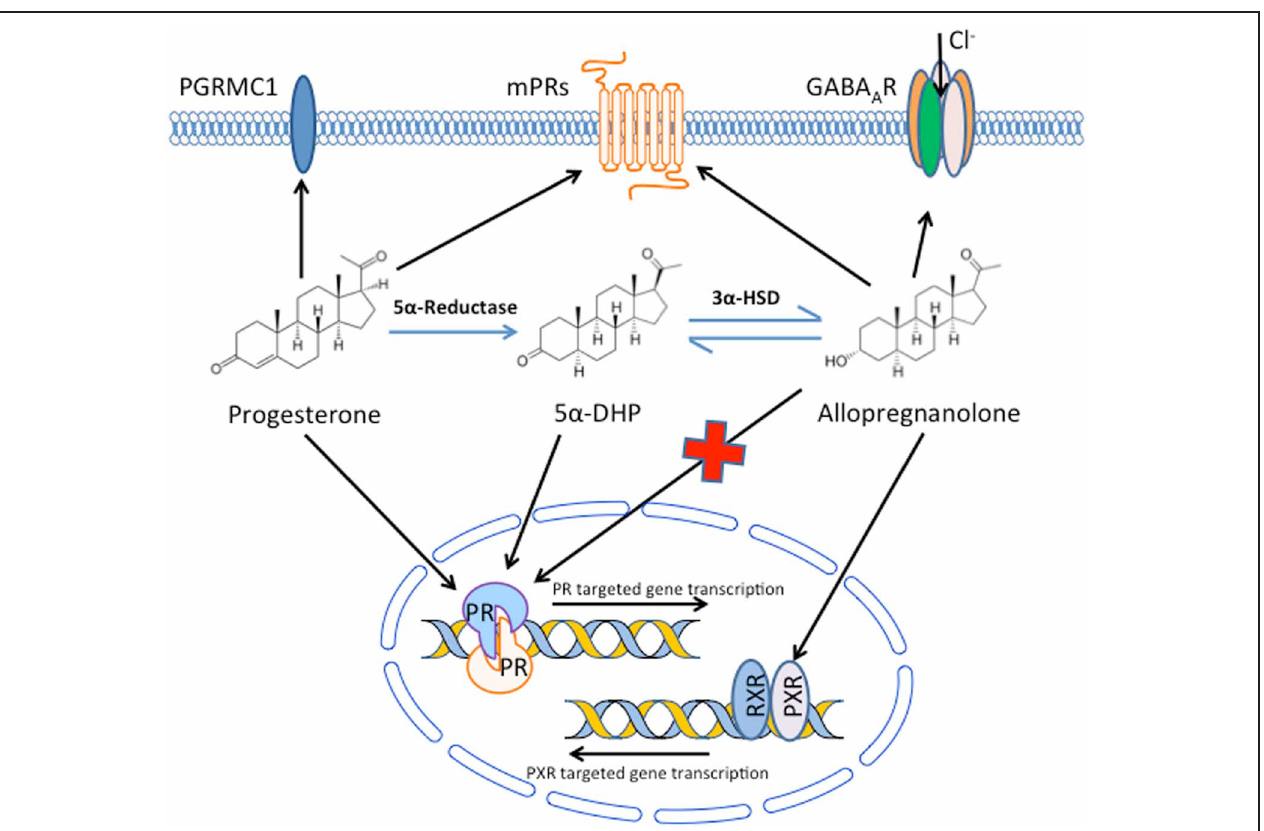
FIGURE 1 | Potential mechanisms by which progesterone and its metabolites signal in the brain to produce beneficial effects following traumatic brain injury. Progesterone, either from the systemic circulation or produced locally in the brain, can bind and signal through the classical nuclear progesterone receptors, but also binds receptors in the plasma membrane, including PGRMC1 and a family ( α – ε ) of membrane progesterone receptors (mPRs). In addition, progesterone can be converted to 5 α -dihydroprogesterone (5 α -DHP) and then allopregnanolone in the brain. Allopregnanolone can bind and alter ion